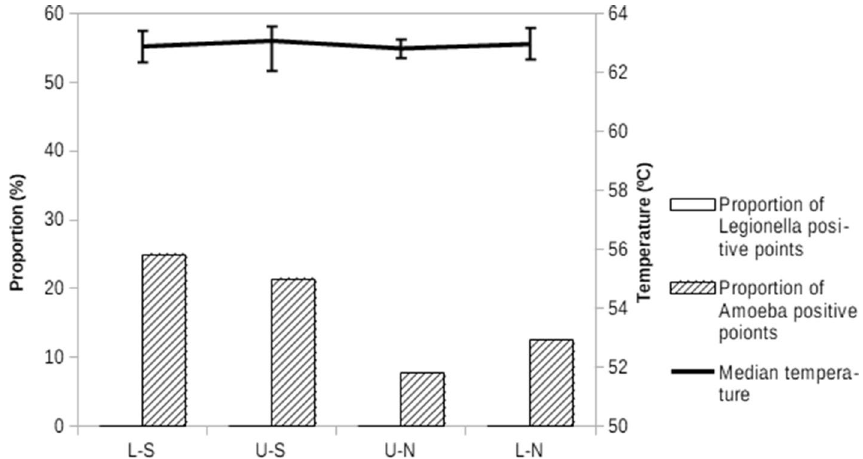
Figure 2. Variations of temperature, Legionella and amoeba colonisation after the implementation of the new measures (temperature increase and change of pipeline material, second year) according to the distance from the hot water tank, defined by the four areas: Lower-South (L-S), Upper-South (U-S), Upper-North (U-N) and Lower-North